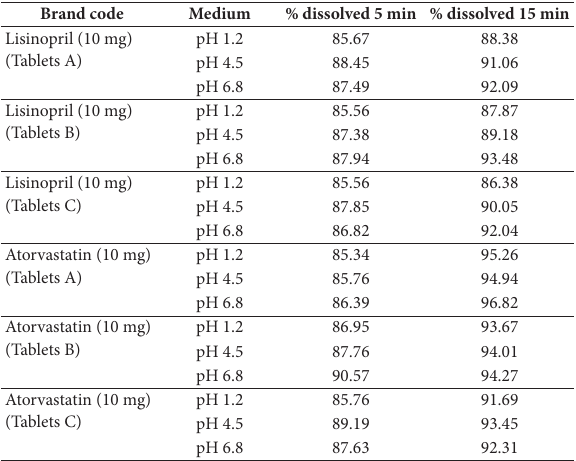
Table 7. Comparative dissolution data of atorvastatin and lisin- opril in selected brands.